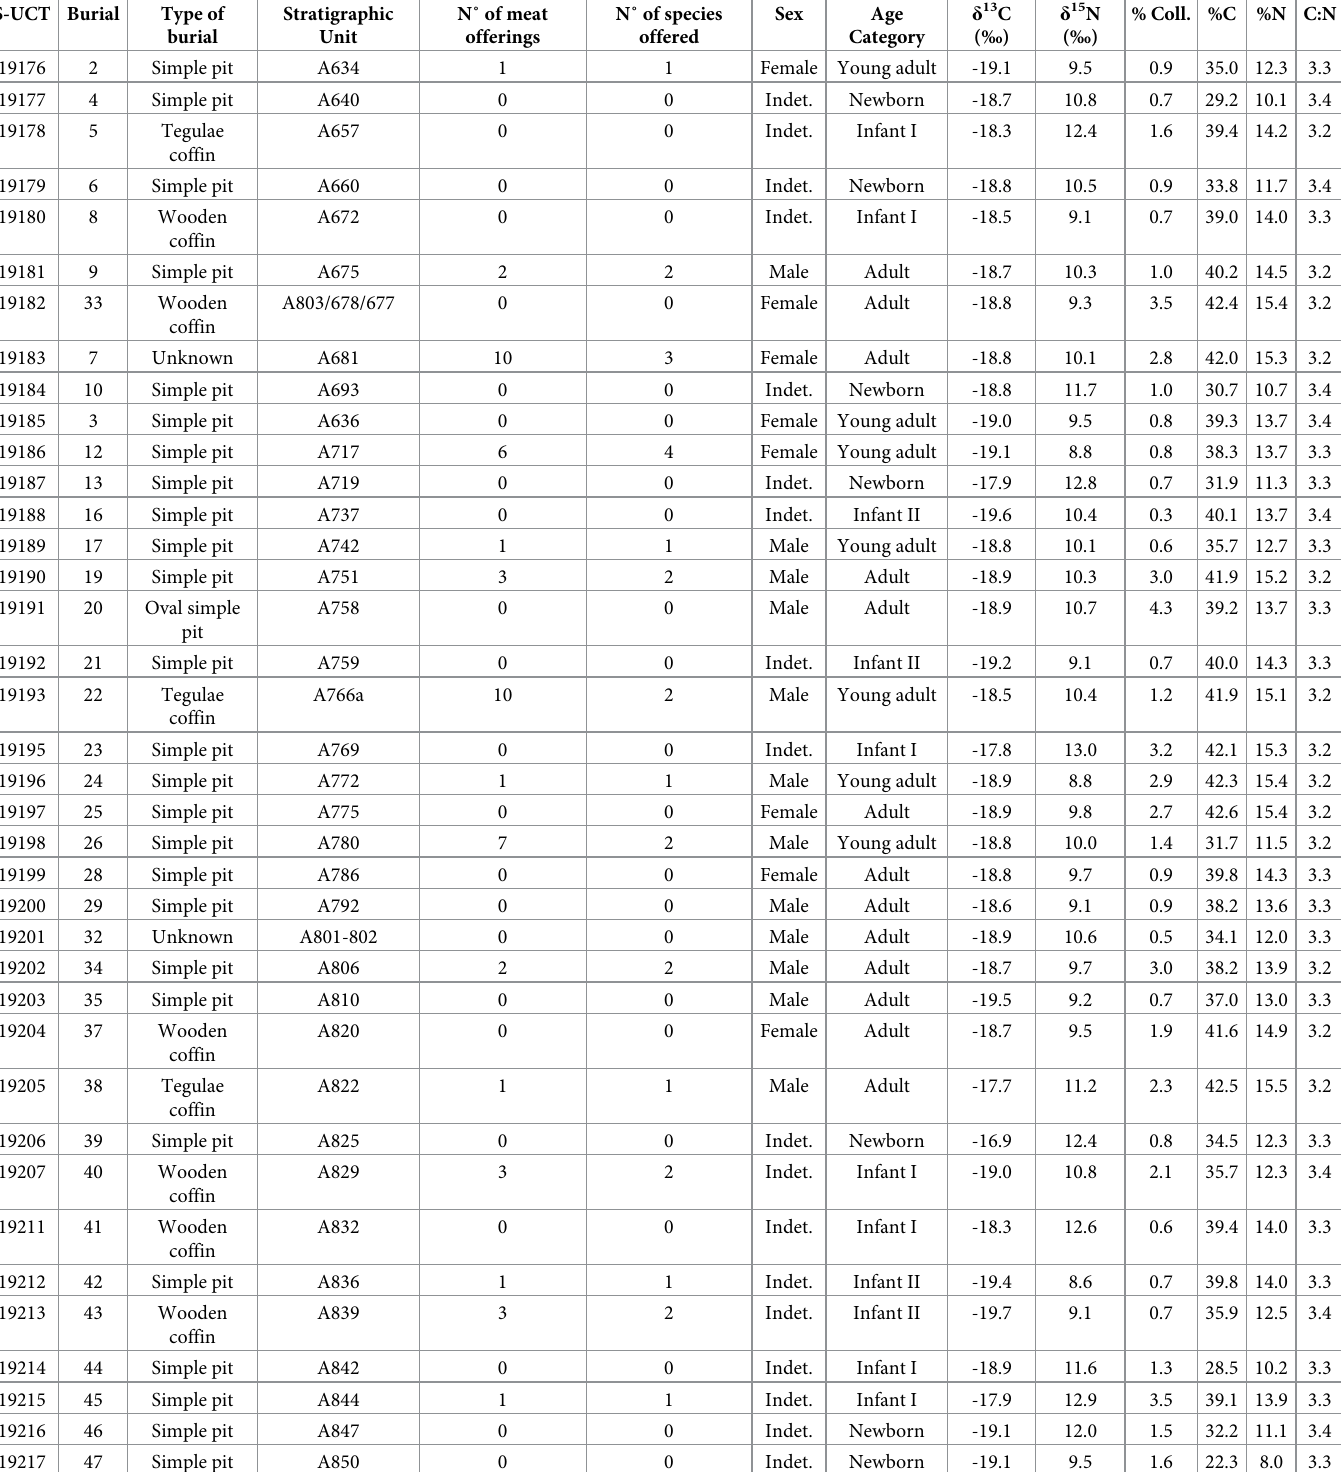
Table 2. Vila de Madrid δ 13 C and δ 15 N values from humans, collagen control indicators (yield, %C, %N, C:N), S-UCT number (lab code), burial number, type of burial, stratigraphic unit, number of offerings, number of species present as offerings, sex and age